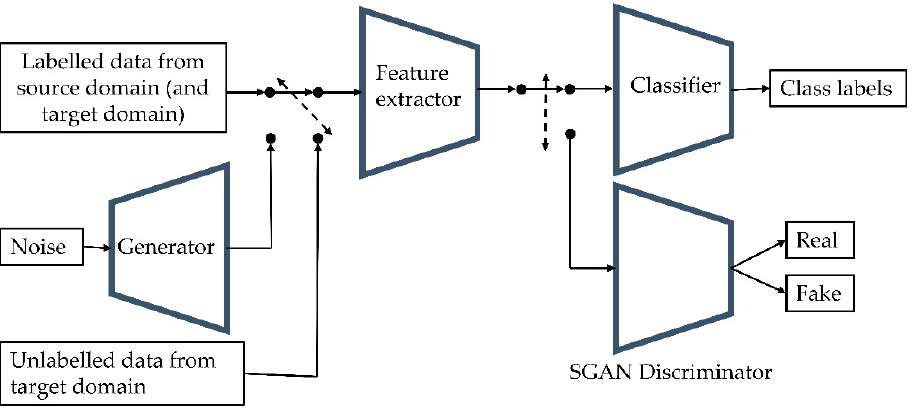
Figure 3. A diagram of the semisupervised generative adversarial network (SGAN) structure and training procedure. The network was trained in three steps, iteratively: (1) the feature extractor and discriminator were trained to classify that the labelled data were real, (2) the feature extractor and discriminator were trained to classify that the generated samples were fake and the generator was trained to confuse the discriminator, (3) the feature extractor and discriminator were trained to classify that the unlabelled target domain data were real.